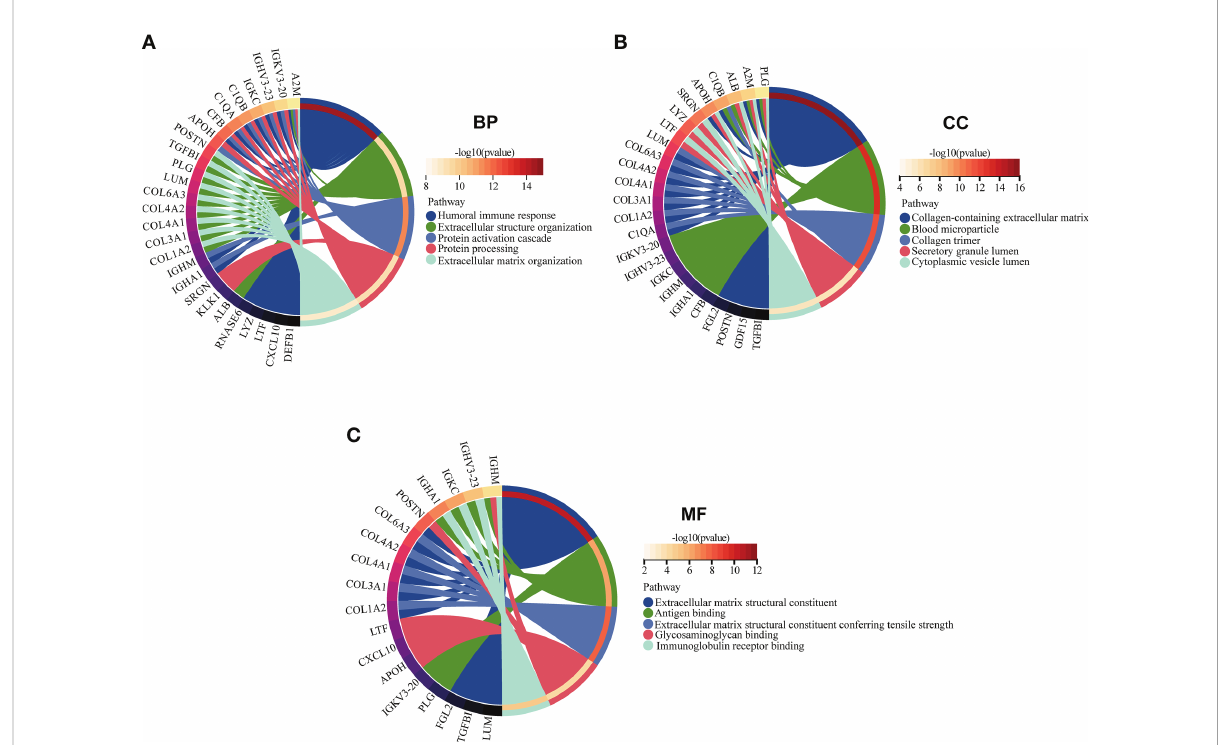
FIGURE 5 GO enrichment analysis of EP-DEGs in BP, CC, and MF (BP, biological process; CC, cellular component; MF, molecular function). (A – C) The circle graph showing the top5 pathway of BP, CC, and MF, respectively. Different color represents different pathway, and the differentially expressed genes in the pathway are